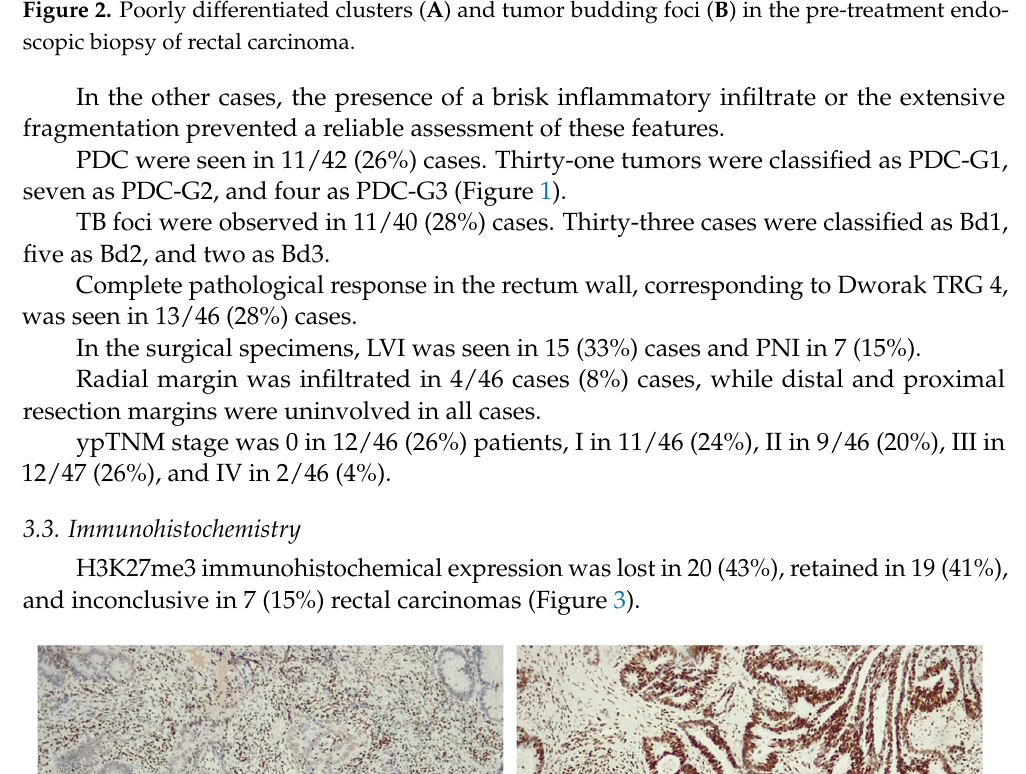
Table 1. Statistical correlations between H3K27me3 immunoexpression and clinical-pathological features of 39 rectal adenocarcinomas treated with neoadjuvant chemo-radiotherapy and surgery. Parameter